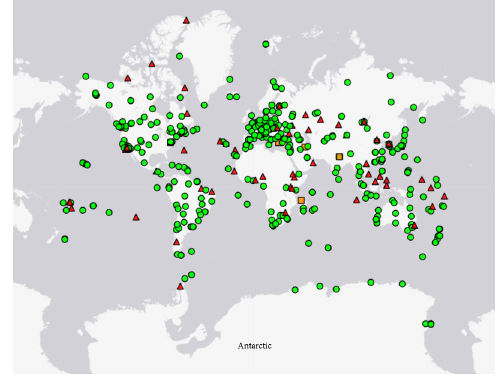
Figure 2. IGS points on the earth